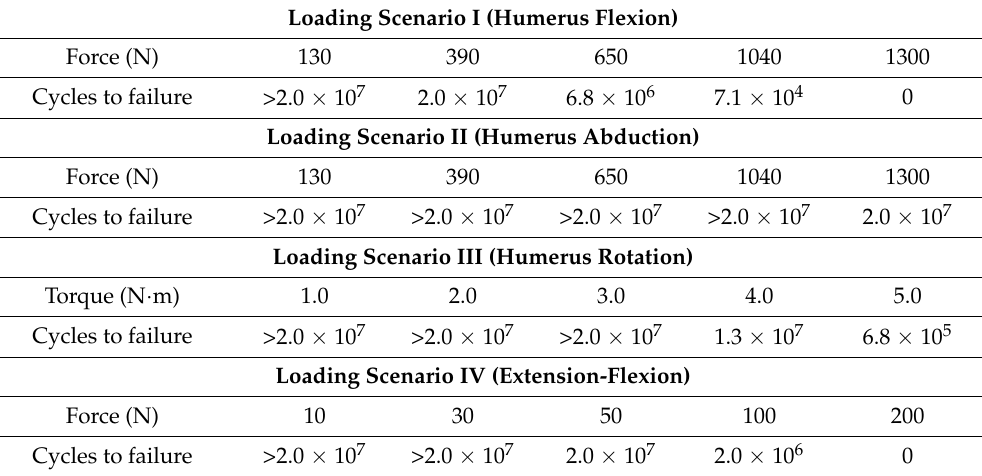
Figure 13. Fatigue life in critical section of the plate: ( a ) Scenario I, 1040 N loading; ( b ) Scenario II, 1300 N loading; ( c ) Scenario III, 5 Nm loading; ( d ) Scenario IV, 100 N loading. Table 4. Life of the LCP according to each